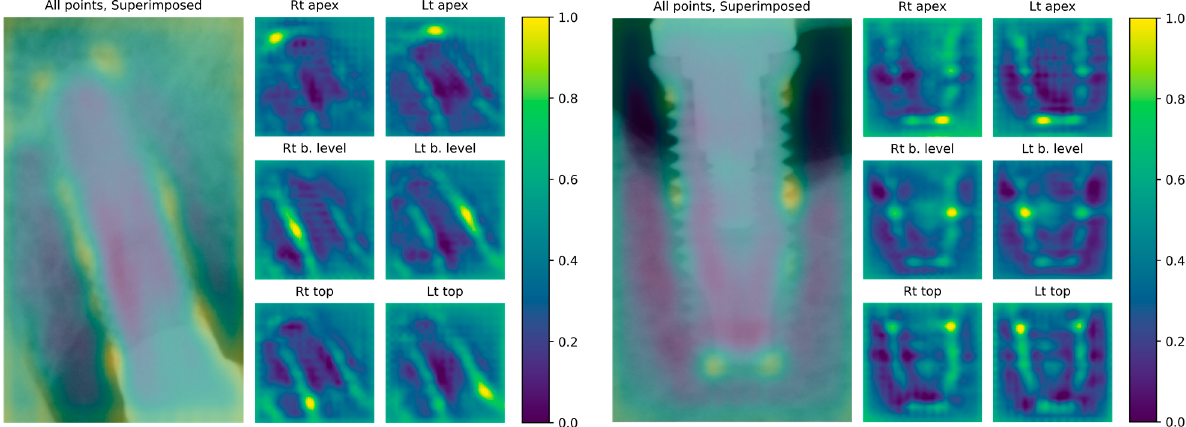
Figure 3. Examples of the keypoint heat maps. The likelihood of each pixel of being a keypoint is mapped into the heat map. Heat maps that combine all keypoints are superimposed on the original radiograph, and individual heat maps for each corresponding keypoint are shown.